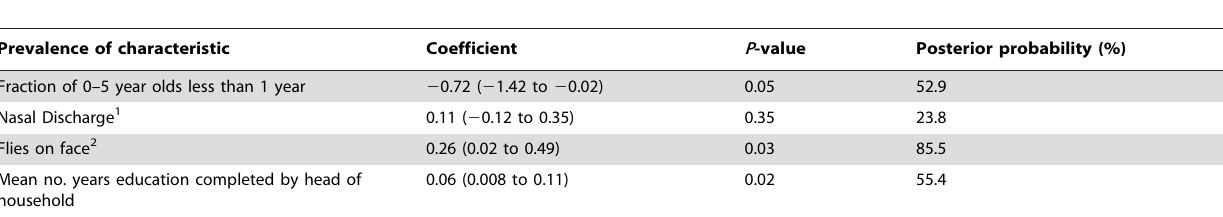
Table 4. Multivariate analysis of chlamydia infection predictors in children 0–5 years in 48 communities in Niger.